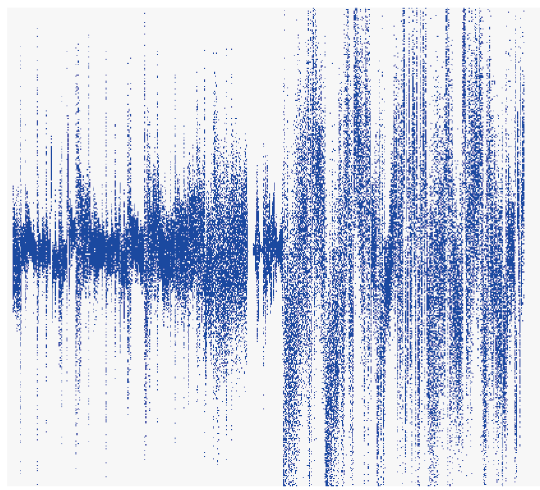
Figure 14. Waveform of the high-quality version of S.